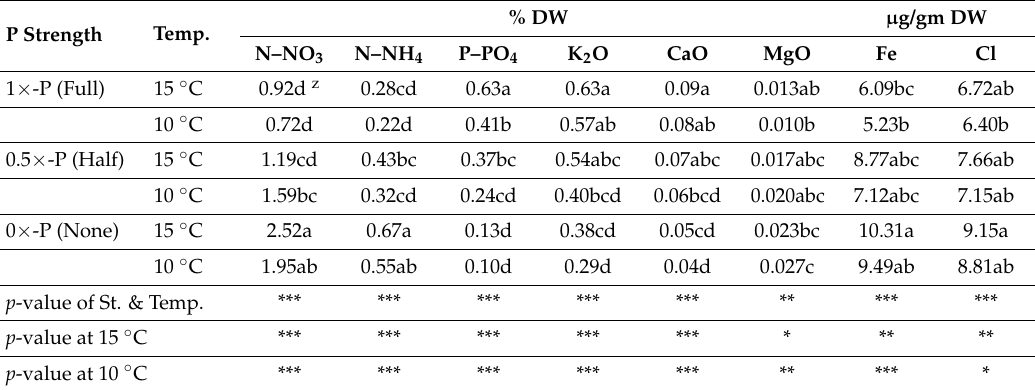
Table 3. Mineral content of red romaine lettuce